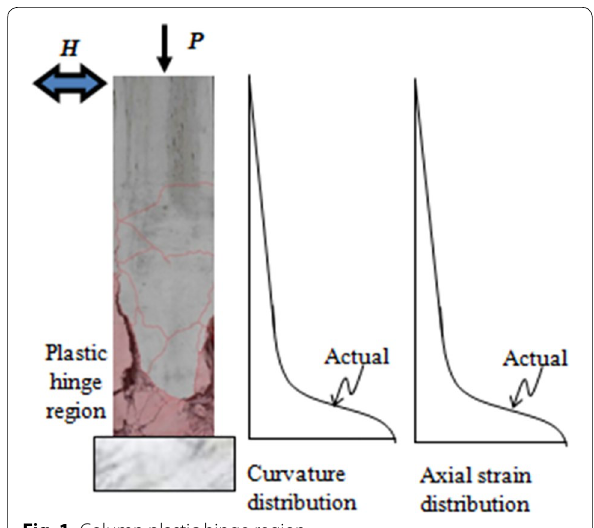
Fig. 1 Column plastic hinge region.